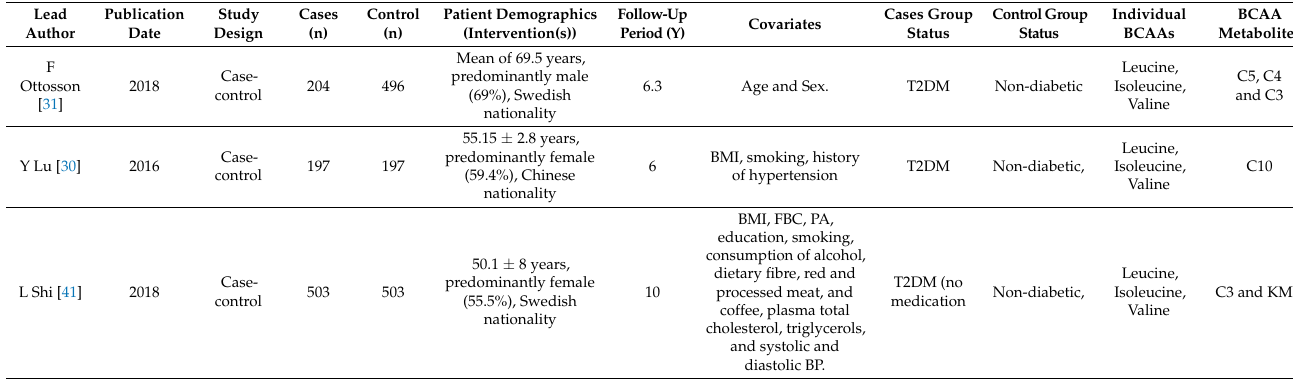
Table 1. Study characteristics of the manuscripts, which reached